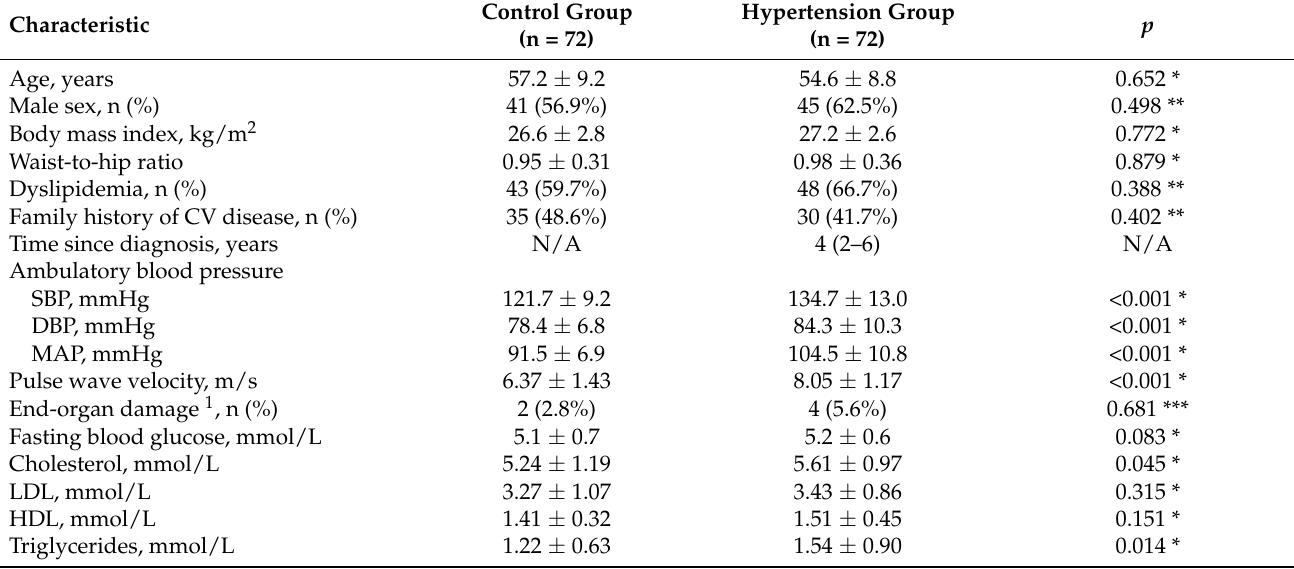
Table 1. Baseline characteristics of the study population.